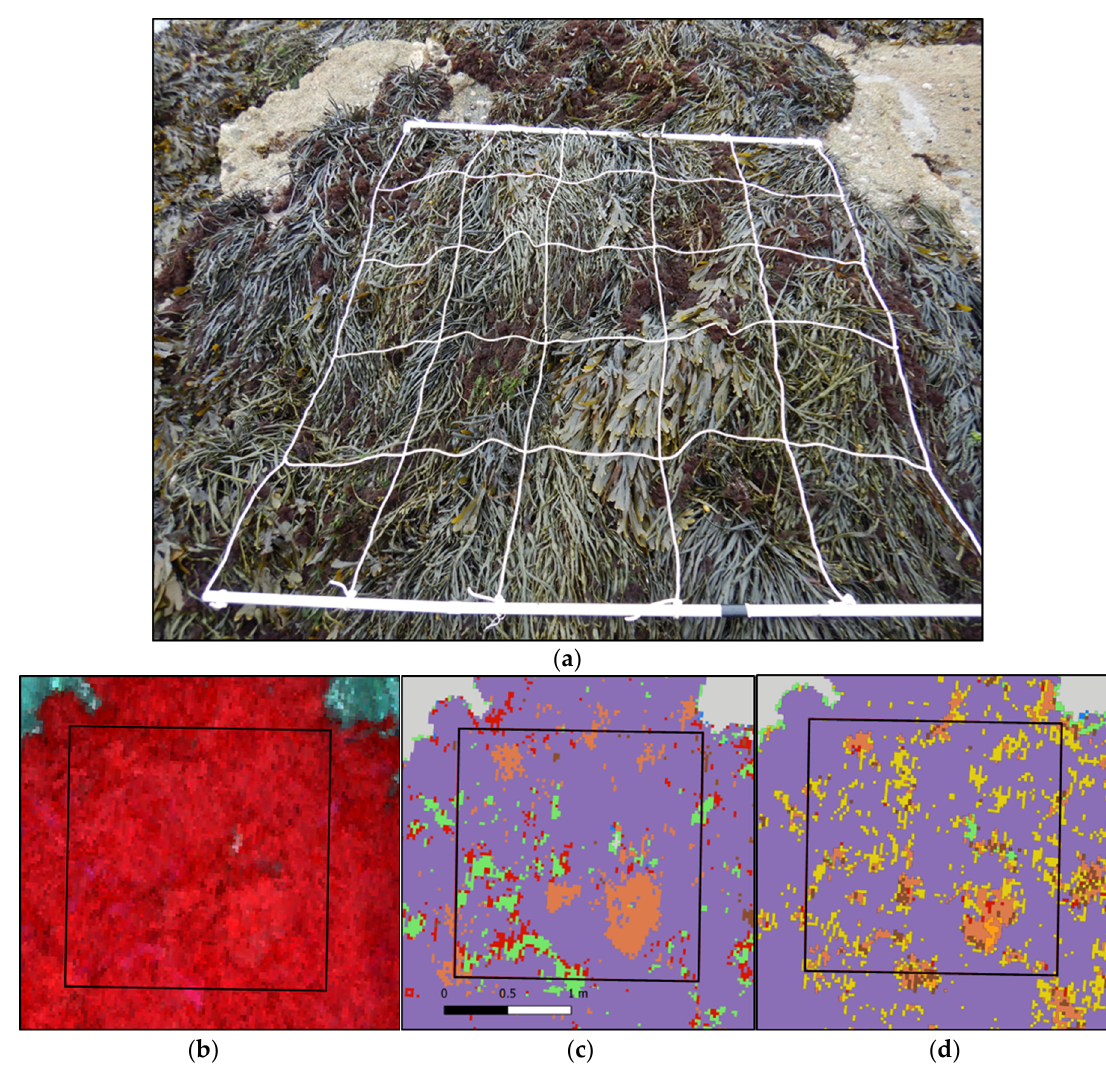
Figure A1. ( a ) Picture of a sampling spot on the An level at Porspoder taken during field sampling in May 2021. ( b ) NIR-G-B image of the same sampling spot. ( c ) Result of the MLC classification. ( d ) Result of the SAM classification. The black square corresponds to the mobile grid structure used for field sampling. Color code in ( c , d ) corresponds to the following classes: ‘ P. canaliculata ’ (brown), ‘ F. spiralis ’ (yellow), ‘ A. nodosum ’ (purple), ‘ F. serratus ’ (Coral), ‘ H. elongata ’ (orange), ‘Red’ algae (red), ‘Green’ algae (green), ‘Substratum’ (grey) and ‘Water’ (blue).